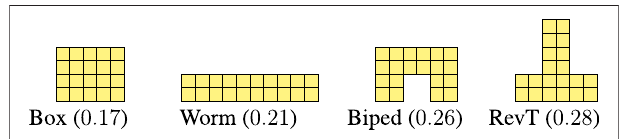
FIGURE 7 | Handcrafted morphologies, designed based on domain knowledge, together with the corresponding value of criticality.